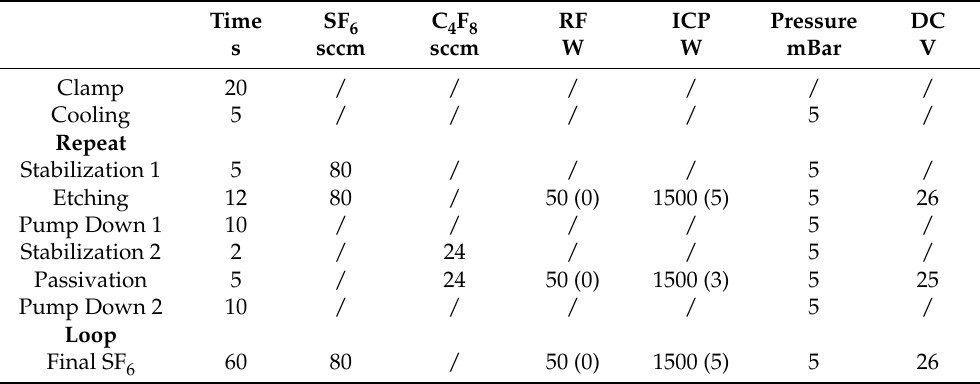
Table 1. Reactive Ion Etching Bosch like process parameters: for each step, duration time, gas fluxes, RF and Inductively Coupled Plasma power and sample potential are